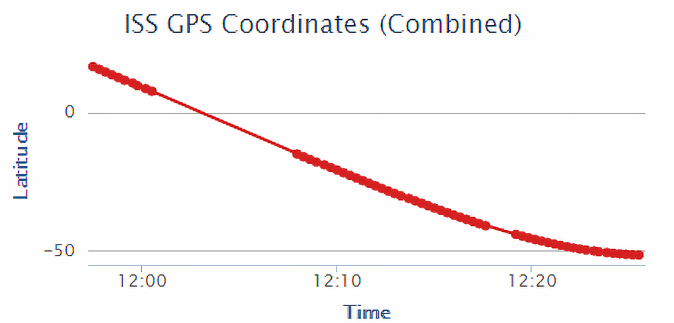
Figure 9. ISS Latitude over a 30-min period. Notice the expected curvature as the latitude approaches − 50°.